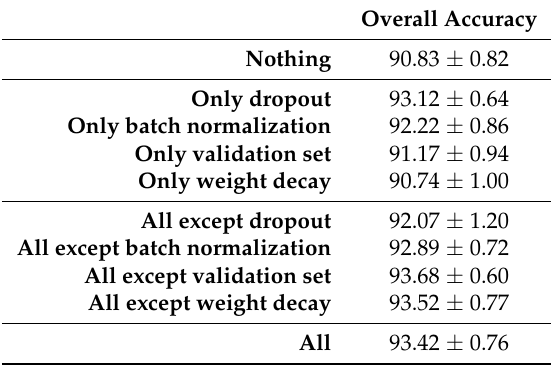
Table 6. Averaged overall accuracy over five runs using different regularization techniques. The first and last rows display Overall Accuracy when all the regularization techniques are turned off and on, respectively. The used dataset is composed of three spectral bands with a regular temporal sampling at two